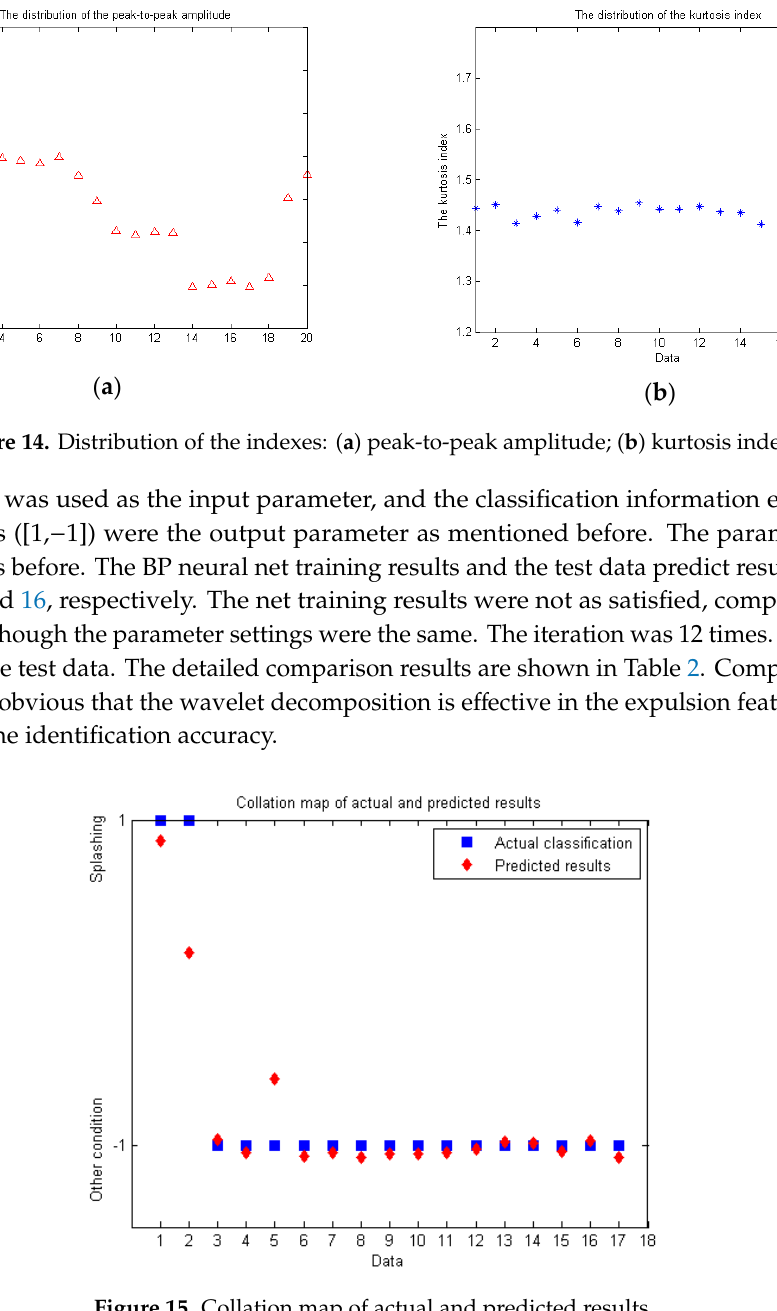
Figure 15. Collation map of actual and predicted results. Table 2. The detailed comparison